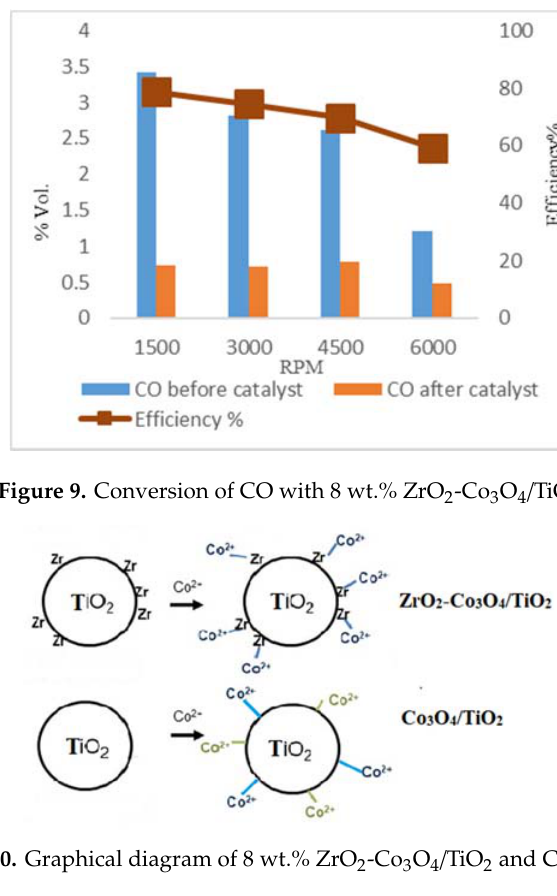
Figure 11. Conversions of NO x , CO, HC to N 2 , CO 2 , and H 2 O on 8 wt.% ZrO 2 ‐ Co 3 O 4 /TiO 2 .